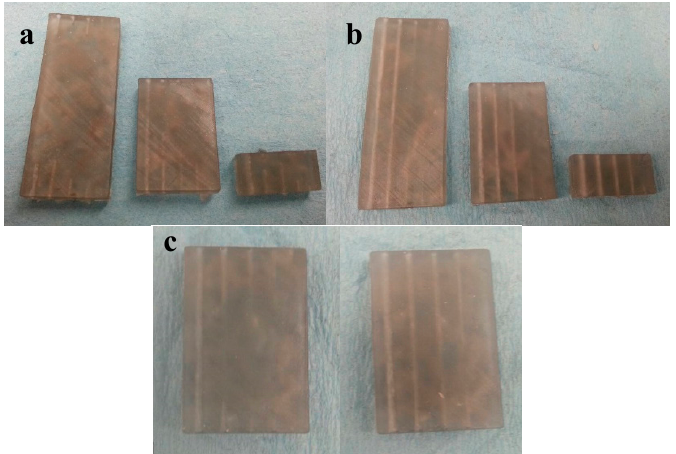
Figure 3. Test Samples containing microchannels with diameters of 2.1 mm, 1.7 mm, 1.4 m, 1.0 mm, and 0.7 mm (right to left). The test chip lengths are 5 cm, 3 cm, and 1 cm. Prolonging the isopropyl alcohol (IPA) soak from 30 min ( a ) to 6 h ( b ) helps with clearing the microchannels from uncrosslinked resin. ( c ) A comparison between IPA soaking cleaning (left) and IPA injection cleaning (right) for the 3 cm long microchannels. IPA injection cleaning achieved superior results in cleaning the channels from uncrosslinked